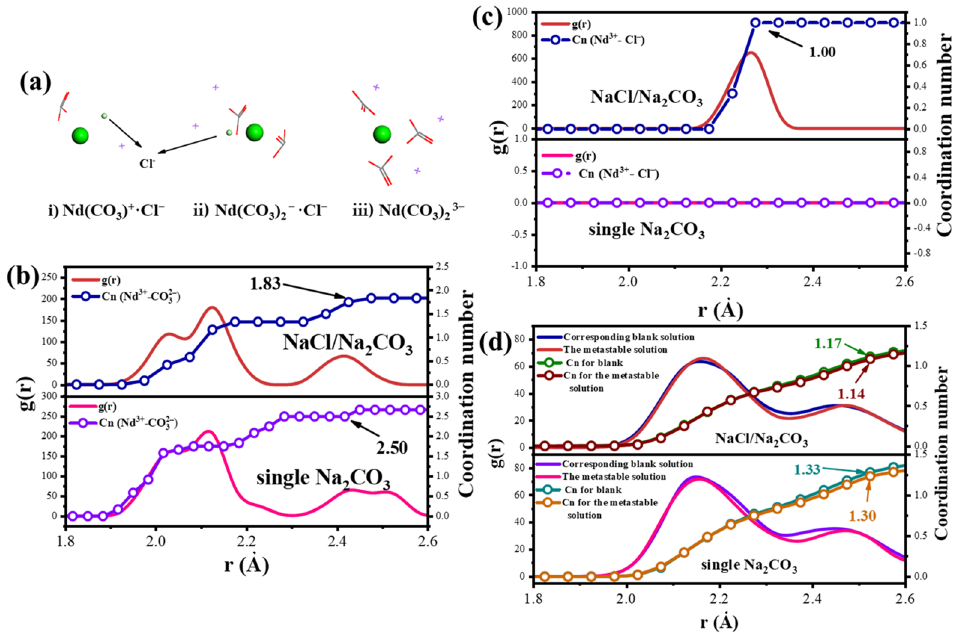
Figure 6. Coordination between Nd 3+ , Cl − & CO 32 − ( a ). RDF of the ion pairs Nd 3+ -CO 32 − , Nd 3+ -Cl − & Na + -CO 32 − and their coordination number ( b – d ), respectively.